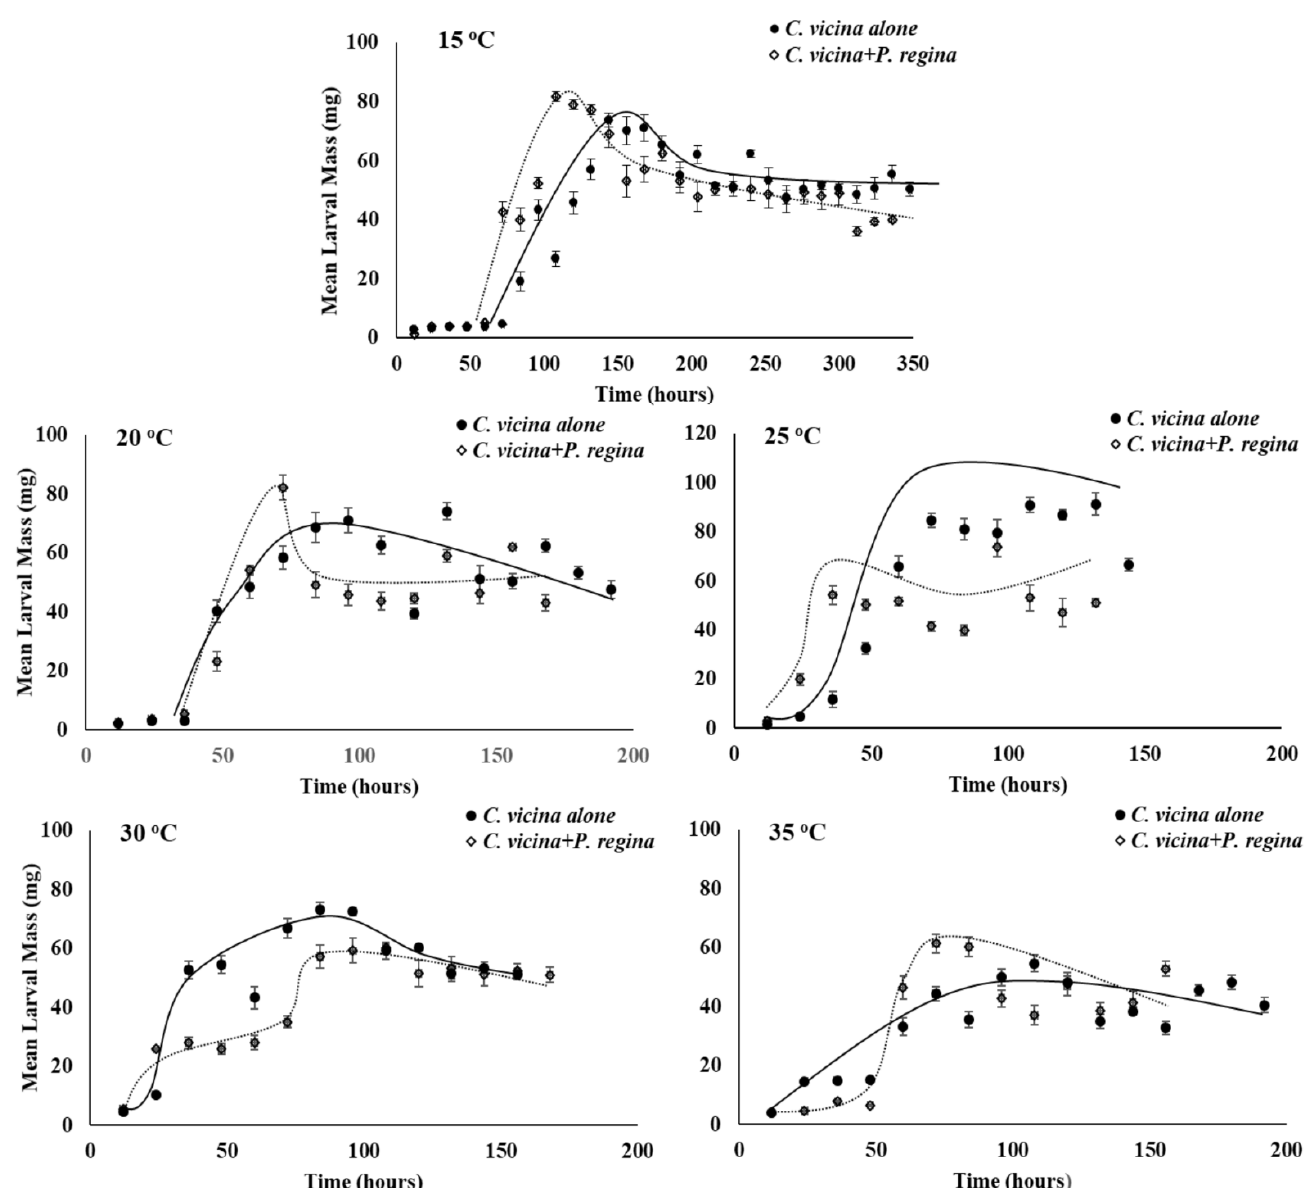
Figure 3. Mean ( ± SE) larval growth rate (mg/time) of C. vicina larvae reared with conspecifics, or reared with P. regina larvae at various temperatures. Indicator variable linear regression with interaction was conducted on the product of larval mass (mg) and time (in h) over time (not shown) for each species treatment and temperature combination. Slope (growth rate) differs at 15 and 25 °C (r 2 = 0.89, F 1,53 = 6.46, p = 0.01; r 2 = 0.93, F 1,19 = 13.5, p = 0.002, respectively). Overall growth rate differs at 25 and 30 °C (r 2 = 0.93, F 1,19 = 14.1, p = 0.001; r 2 = 0.94, F 1,23 = 5.44, p = 0.03, respectively).